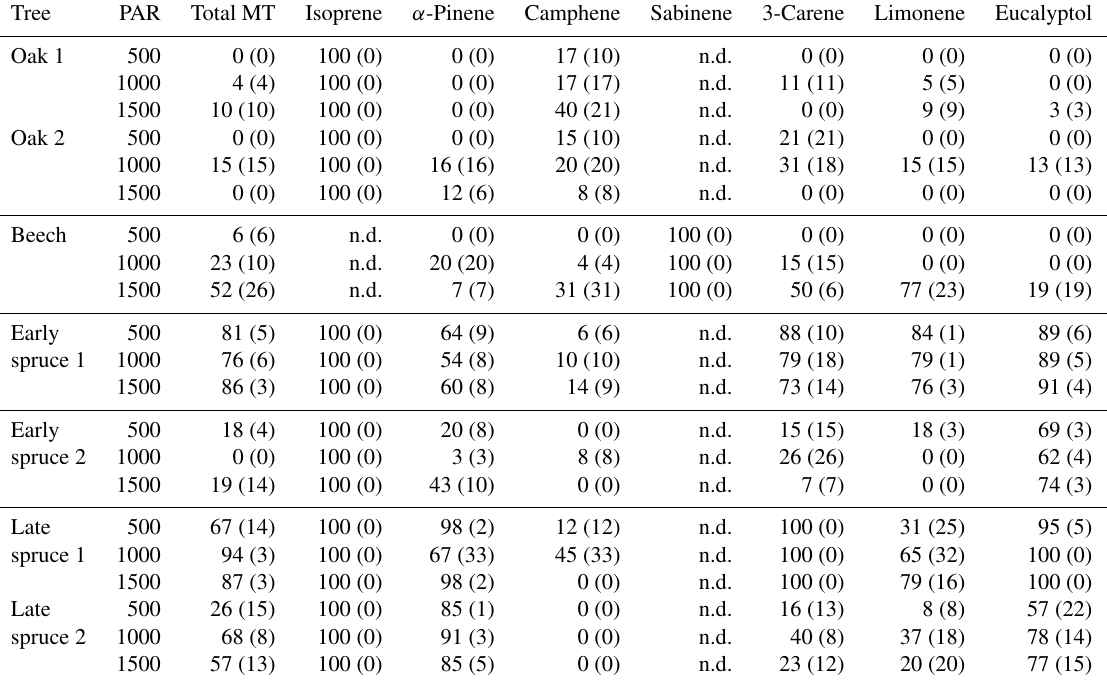
Table 2. The percentage of emissions that are dependent on light (PAR, in µmolm − 2 s − 1 ), as determined for the total monoterpene (MT) emission and for the main emitted compounds. The percentage was calculated as 100% × (light emissions − dark emissions) / light emissions. The numbers in brackets are the standard error of the mean. The trees that were measured were two individuals of English oak ( Quercus robur ), one European beech ( Fagus sylvatica ), two individuals of Norway spruce ( Picea abies ) with an early budburst (early spruce) and two individuals of Norway spruce with a late budburst (late spruce). No data (n.d.) indicates compounds that were not detected in any sample or light level for that particular